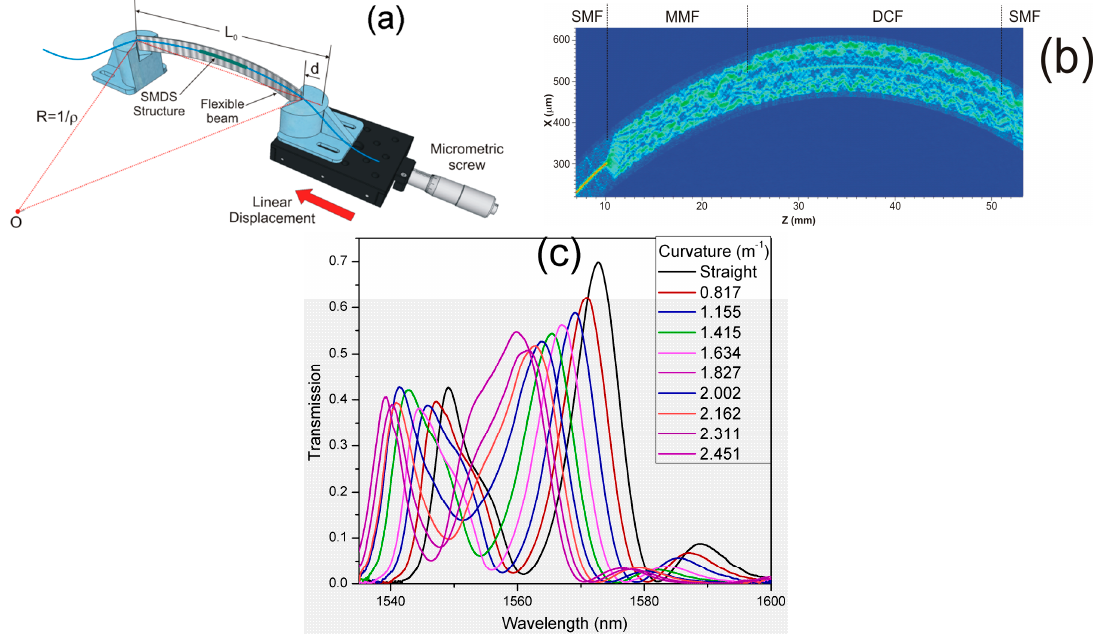
Figure 4. ( a ) Schematic of the mechanical system for curvature application; ( b ) BPM simulation of the bent SMDS structure; ( c ) Transmission of the SMDS structure under curvature variations.